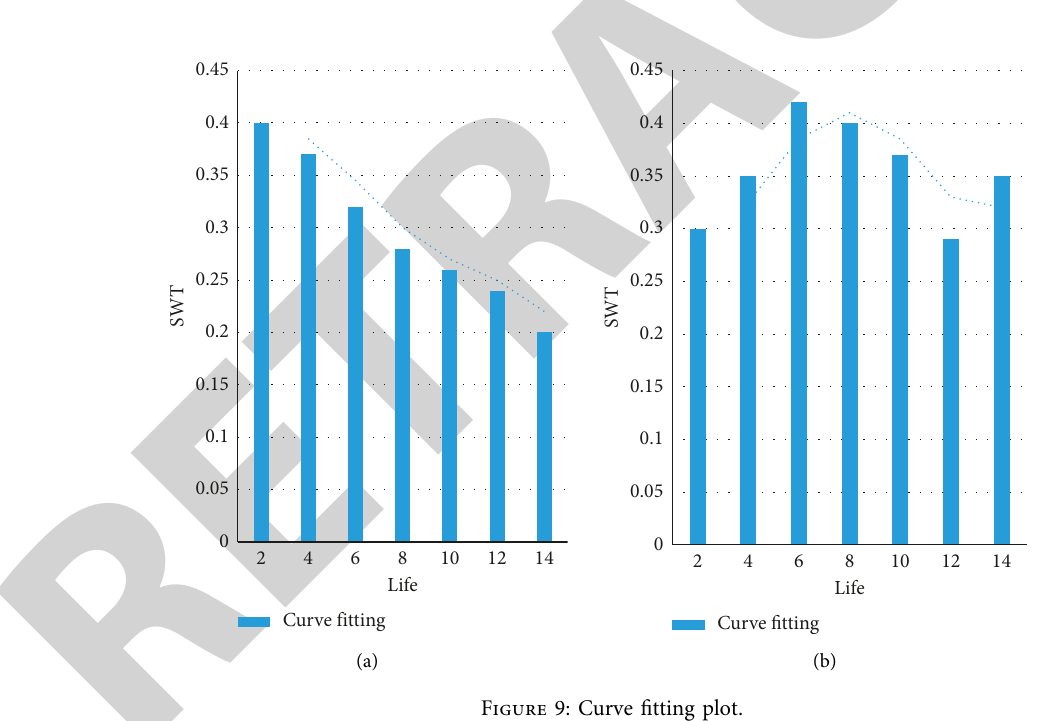
Figure 9: Curve fitting